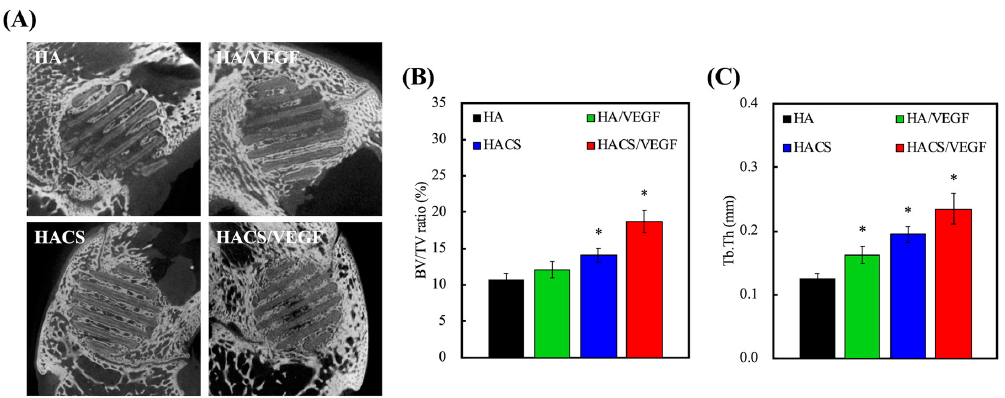
Figure 9. Evaluation of bone formation in vivo. ( A ) Micro-CT images at week 8. ( B ) Micro-CT- Figure9. Evaluationofboneformationin vivo. ( A )Micro-CTimagesatweek8. ( B )Micro-CT-quantified quantified histograms of ( C ) bone volume/total volume (BV/TV) and trabecular thickness (Tb.Th). “*” histograms of ( C ) bone volume / total volume (BV / TV) and trabecular thickness (Tb.Th). “*” indicate a indicate a significant difference ( p < 0.05) when compared to HA.